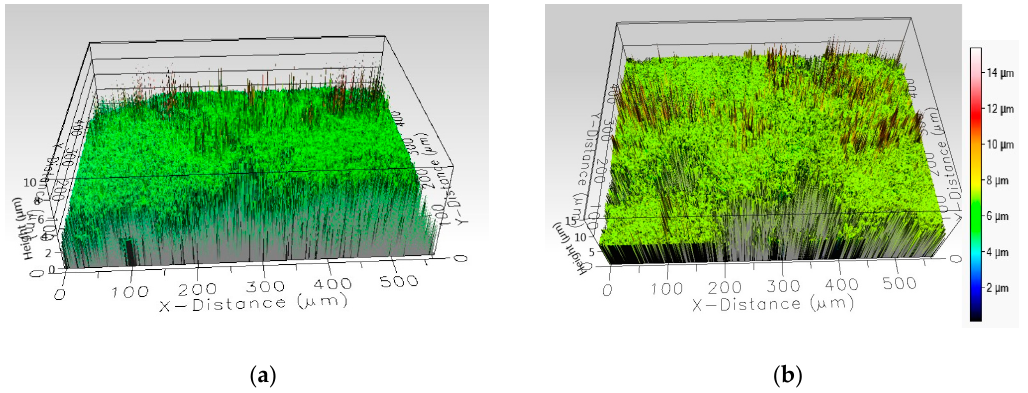
Figure 3. 3D surface profile of ( a ) EC-CB and ( b ) PS-CB for topographical analysis, generated on Filmetrics Profilm 3D.